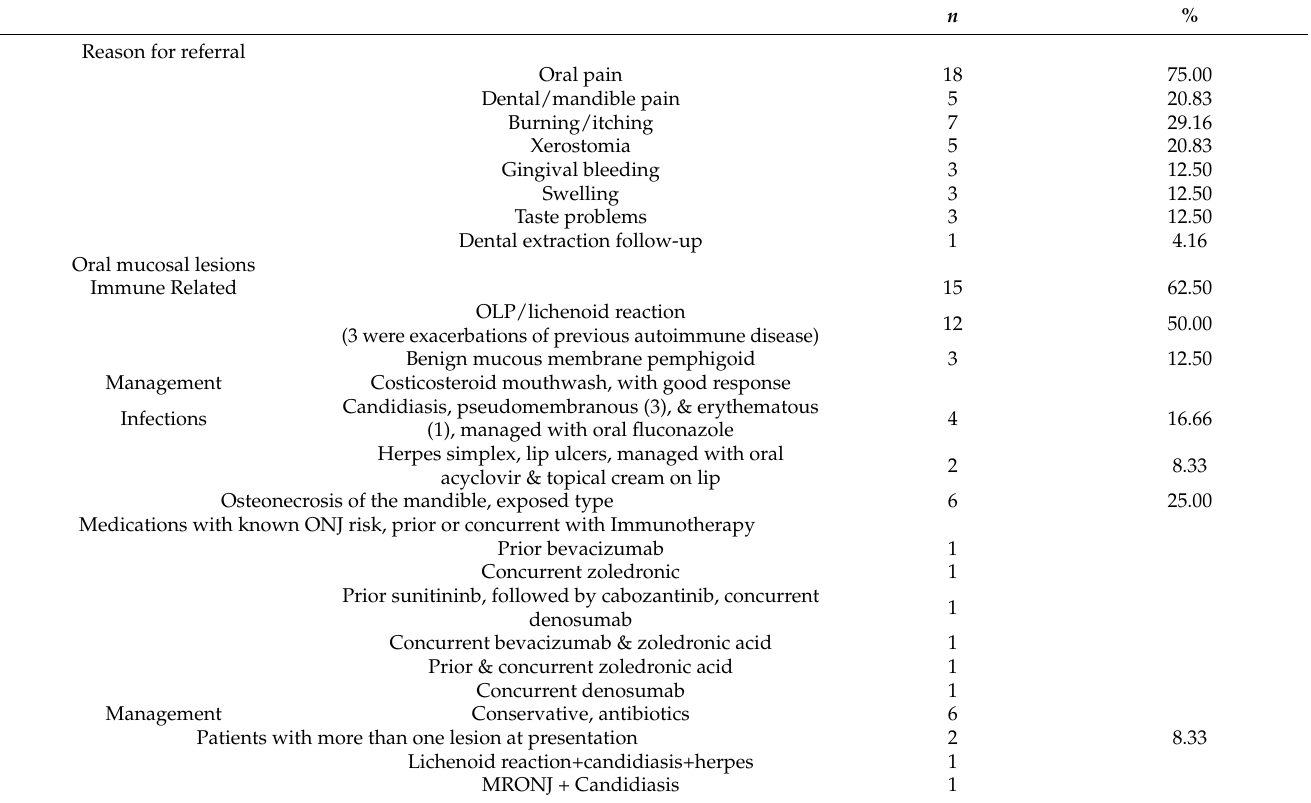
Table 2. Reason for referral, diagnosis of oral lesion and management, n = 24.